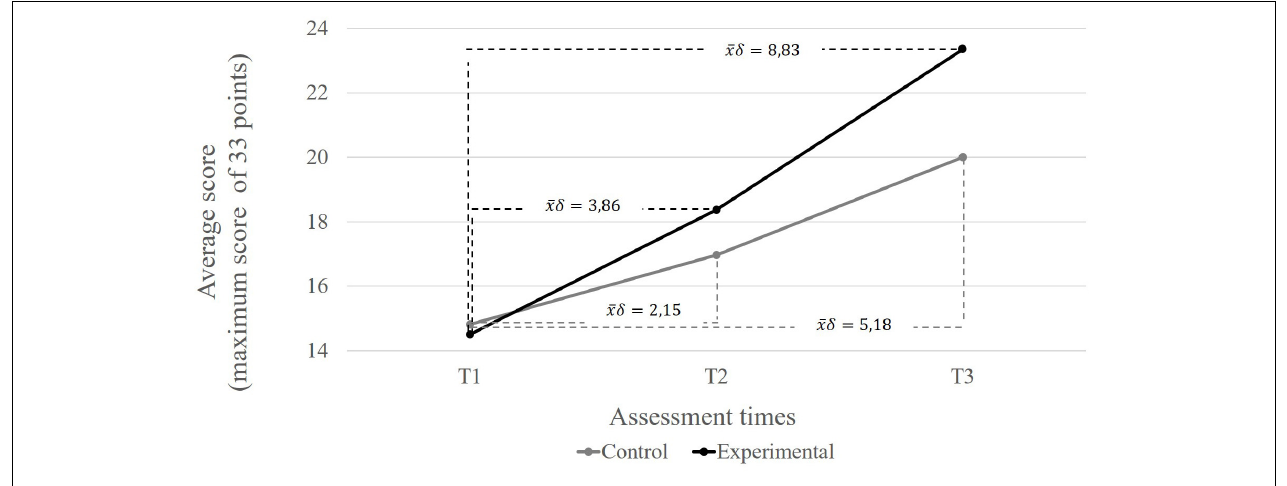
FIGURE 4 | Average growth deltas observed in each group at each assessment time.